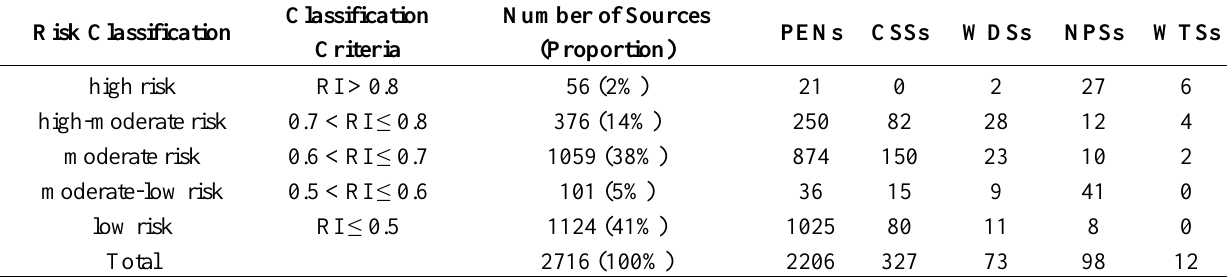
Figure 4. The distribution of RI values of all pollution sources in the study area. Table 5. Risk classification criteria and the proportion of each class of